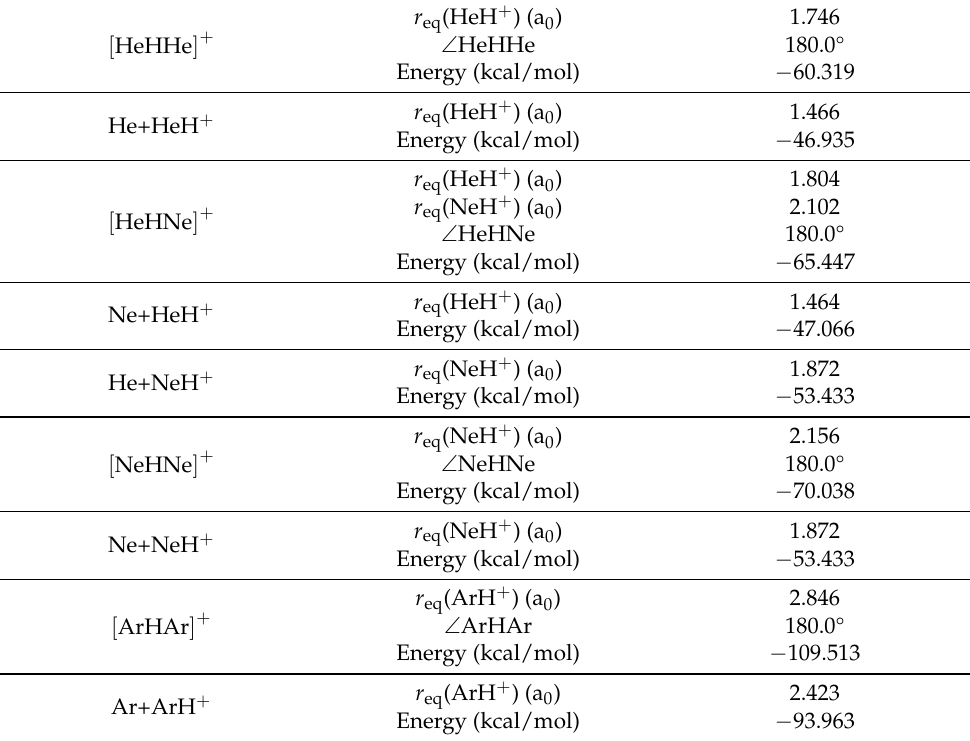
Figure 2. Color maps of the potential energies computed from the analytical PESs for different reactive systems. The diatoms are at their equilibrium geometry and placed on the “X” axis and the origin of each plot is set to the center-of-mass of the diatoms. The zero of energy is set to the asymptotic energy of the reactant channels for each plot. The blue regions have positive energies while the red regions have negative energies. Unique color-box is used for all the panels and is shown in top-right panel. Table 2. Details of the global minima and reactant/product asymptotes obtained from the analytical PESs. The zero of energy is set to the energy of Rg+Rg’/Rg+H + for each